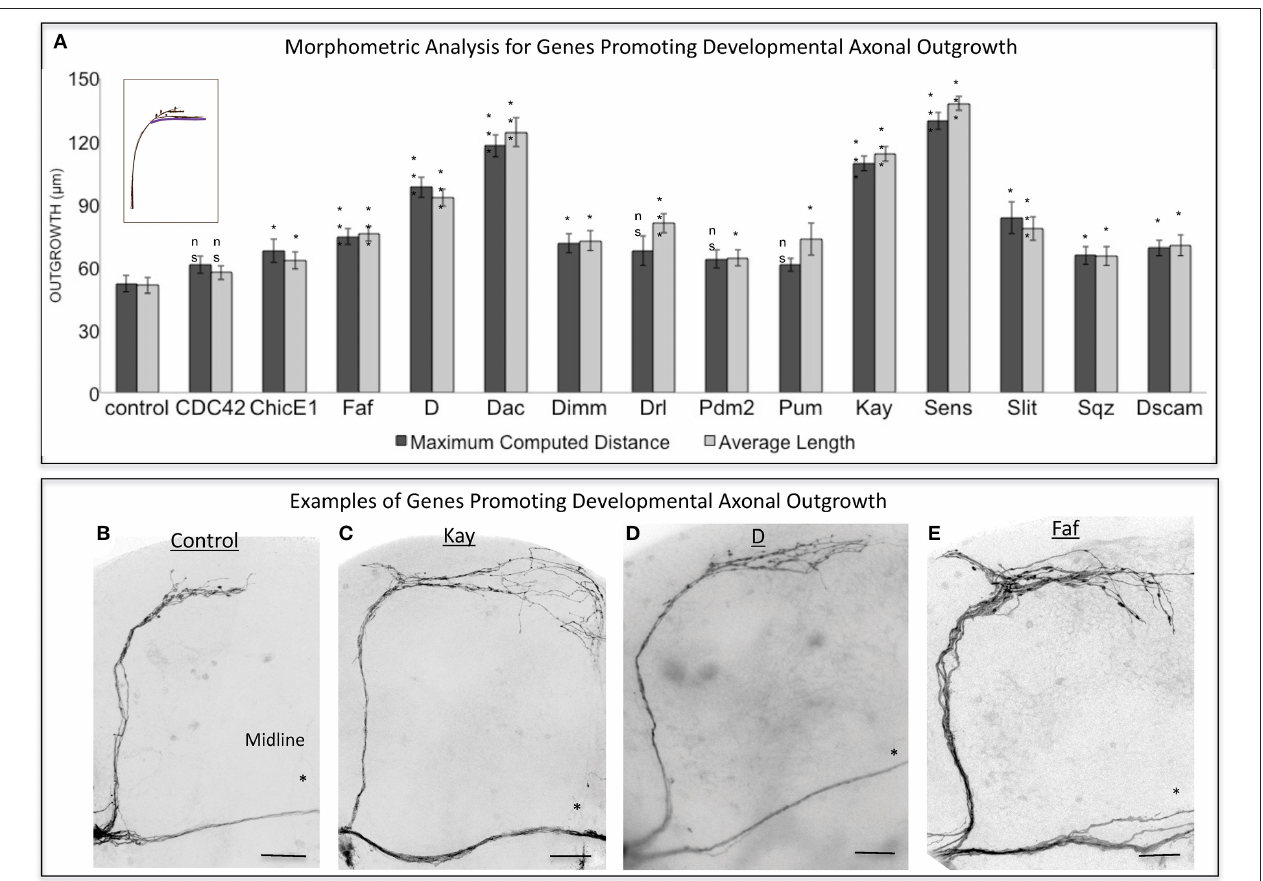
FIGURE 2 | Analysis of axonal outgrowth in the developmental screen. (A) Morphometric analysis (Maximum Computed Distance and Average Length) of sLNv axonal projections where developmental overexpression of candidate genes has been specifically induced in the sLNvs. Axonal outgrowth is measured in µ m. Purple trace in schematic represents measured axonal length. (B–E) Representative images of sLNv axonal arborization in wild type (control) adult flies (B) and in flies where developmental overexpression of Kayak , kay (C), Dichaete , D (D) and Fat Facets , faf (E) has been specifically induced in the sLNvs. Scale bars are 20 µ m. Genotype of flies in (B) is PDF-Gal4, UAS-GFP/ + ; PDF-Gal4, UAS-2x eGFP/ + , in (C) is PDF-Gal4, UAS-GFP/ + ; PDF-Gal4, UAS-2x eGFP/ + ; UAS-Kay/ + , in (D) is PDF-Gal4, UAS-GFP/ + ; PDF-Gal4, UAS-2x eGFP/ + ; UAS-D/ + , in (E) is PDF-Gal4, UAS-GFP/ + ; PDF-Gal4, UAS-2x eGFP/ + ; UAS-Faf/ + . Asterisk denotes the brain midline. * p < 0.05; *** p < 0.001. n.s. indicates no statistical significance. Error bars represent SEM. Scale bars are 20 µ